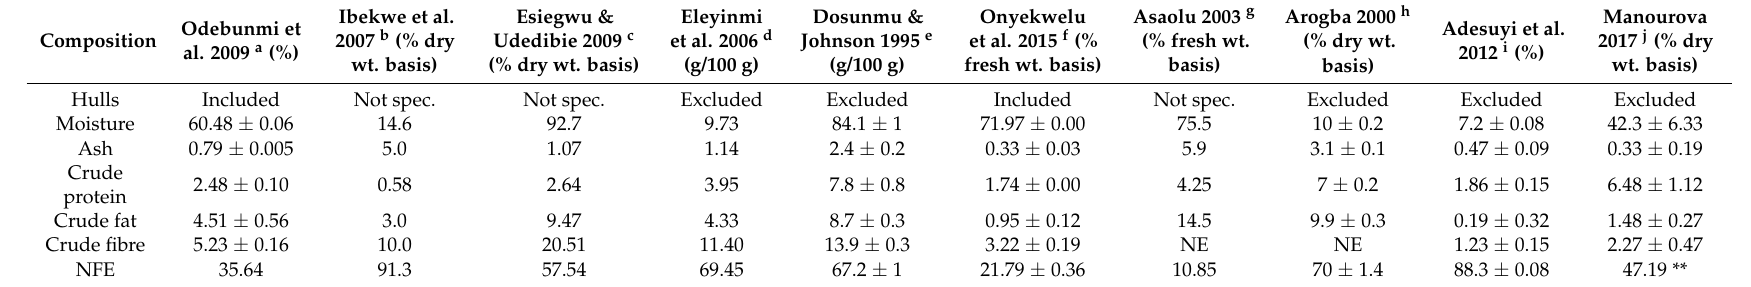
Table 2. Mean nutritional composition of G. kola seeds reported by various authors.